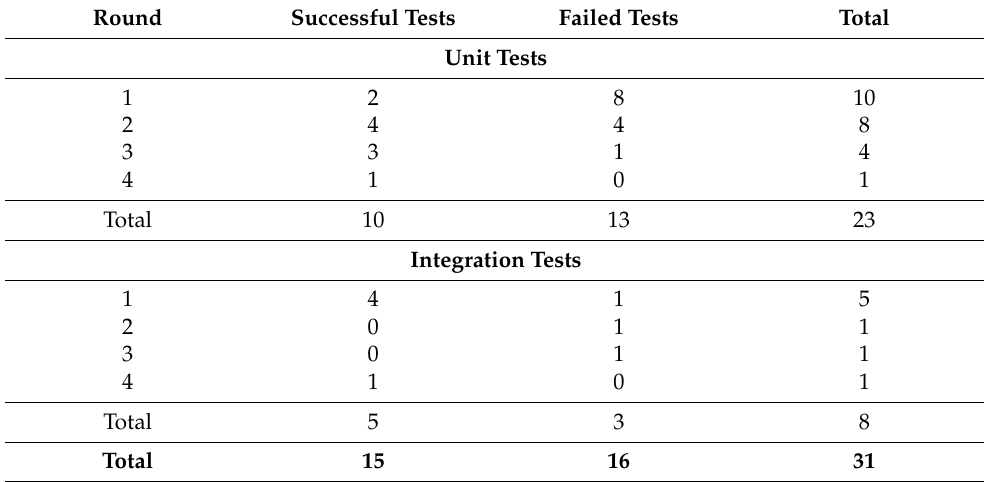
Table 2. Table of tests performed during the first